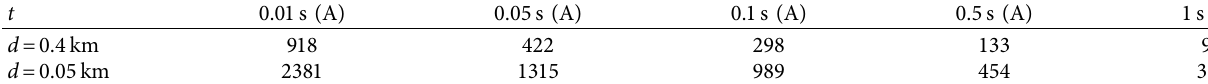
Table 3: Estimated cumulative RMS values of inrush currents for the two numerical cases of this example.